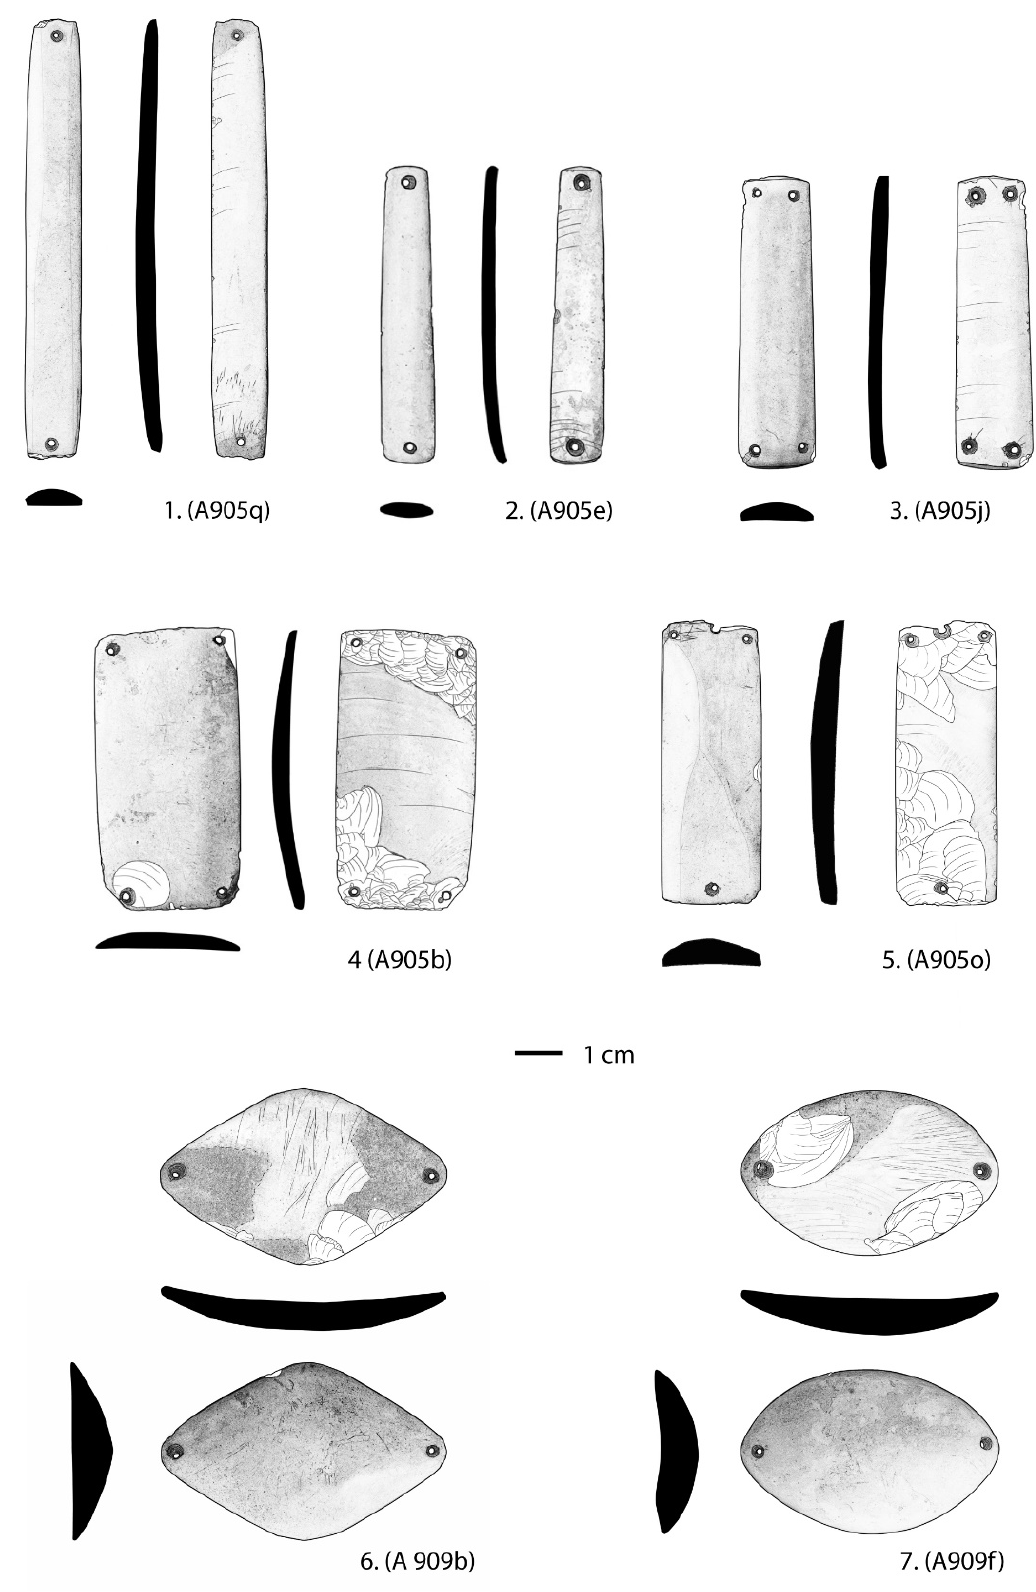
Figure 5. Nos. 1-5. A selection of rectangular links from Burnt House at Tell Arpachiyah. Note that No. 5 was broken across the original central perforation and subsequently re-perforated at either side to maintain the length when mounted. Nos. 6 and 7 examples of lozenge and oval shaped links from Tell Arpachiyah (Drawings by Steve